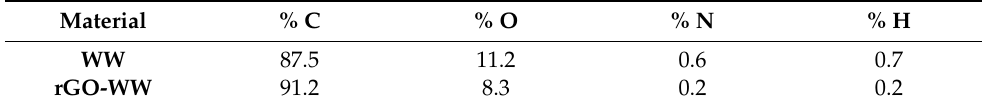
Table 1. Elemental composition of the activated carbons.